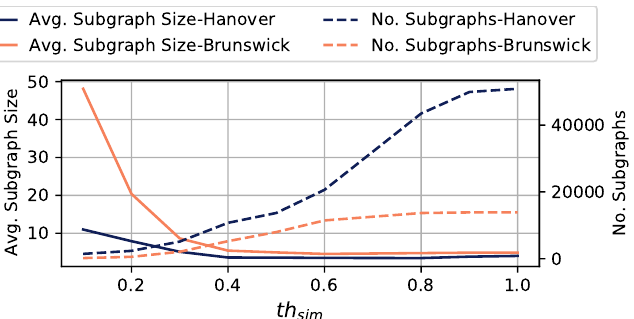
Figure 9. Influence of th sim in Algorithm 1 on the number of subgraphs and an average subgraph size.